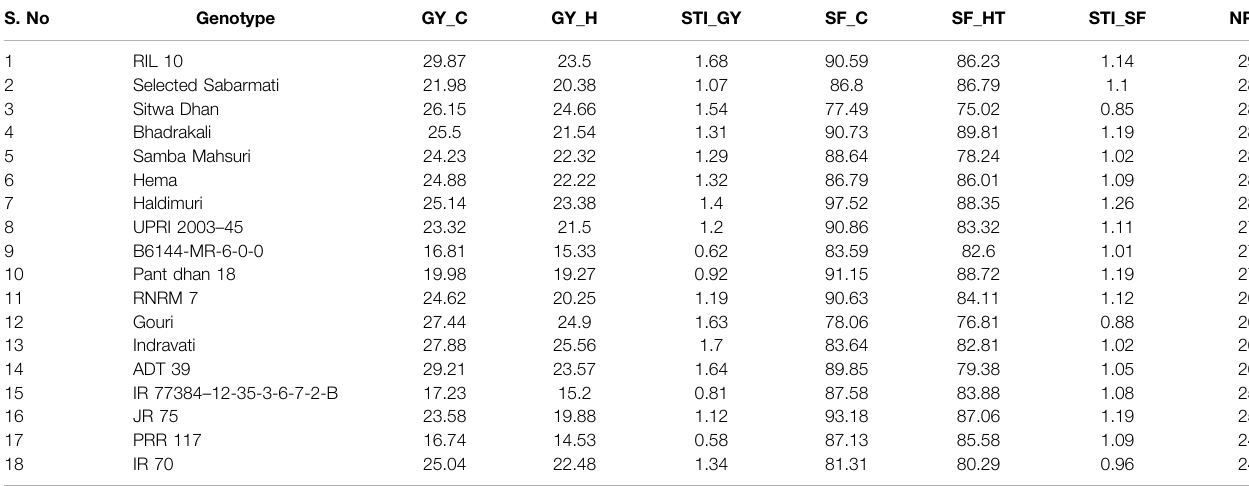
TABLE5| Listofbest-performinggenotypesintermsofgrainyield,spikeletfertility,andtheirrespectivetoleranceindicesandnumberofpositiveallelesof29MTAsidenti fi ed for RSHT. S.